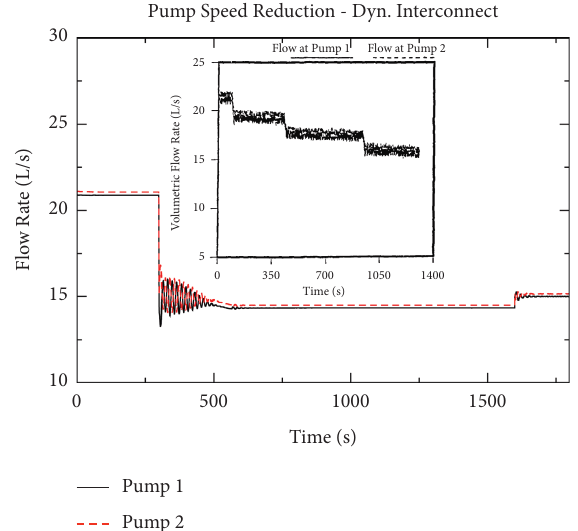
Figure 40: Flow oscillations with reduced pump speed with dynamic similarity interconnect. Experiment inset